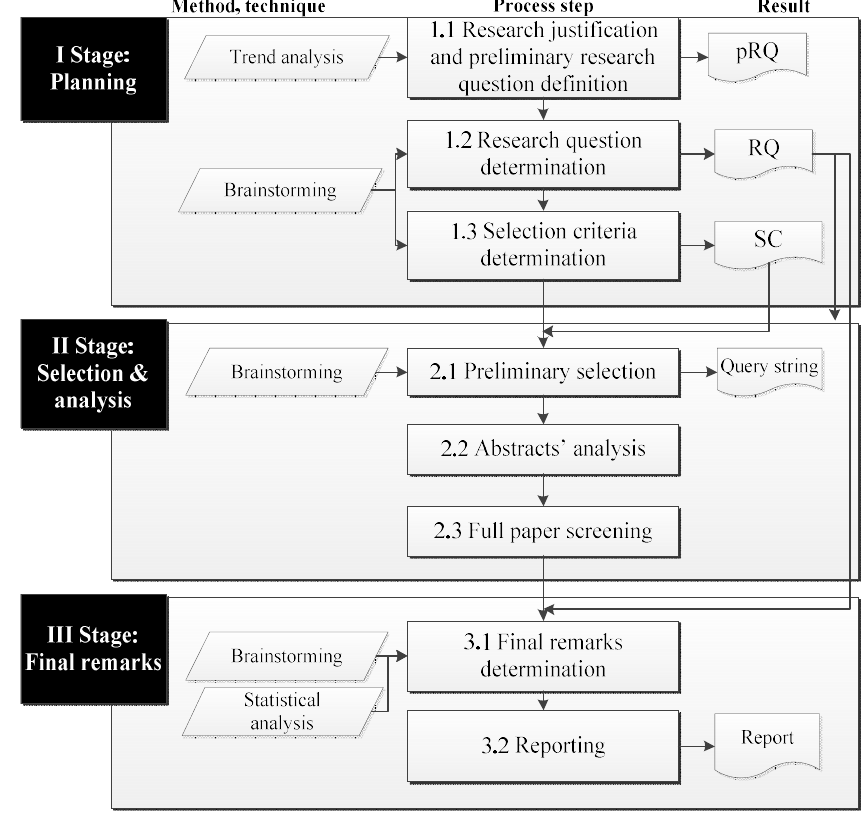
Figure 4. Research methodology.